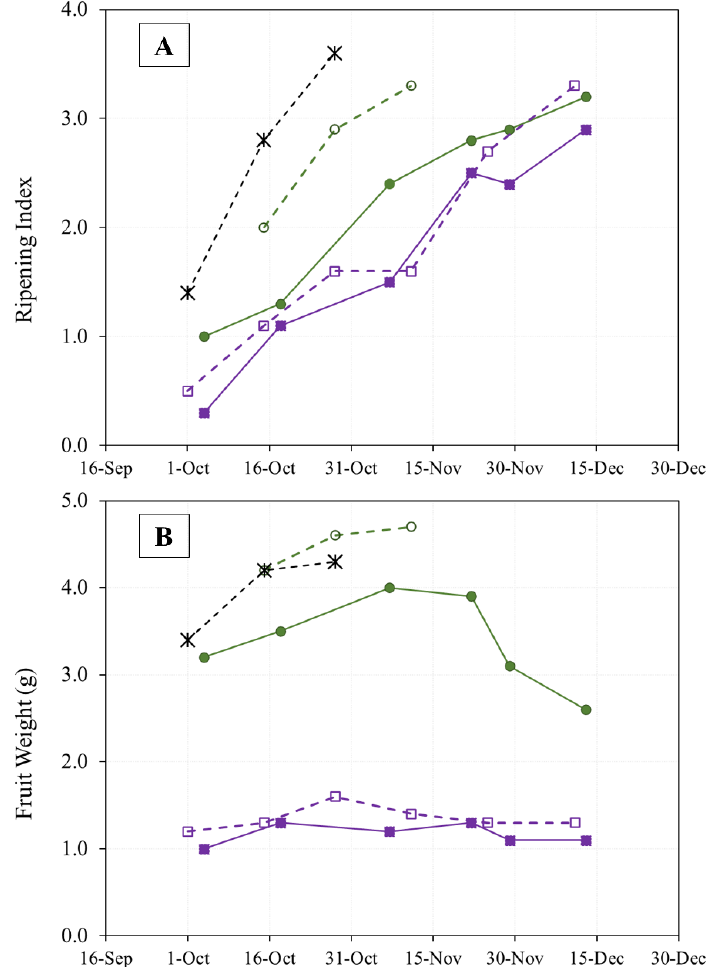
Figure 2. Evolution of olive fruit ripening ( A ) and fruit weight ( B ) of “Arbequina” (square; violet), “Royal de Calatayud” (circle; green), and “Negral de Sabiñán” (cross; black) harvested at different dates in 2017 (continuous line) and 2019 (dotted line).